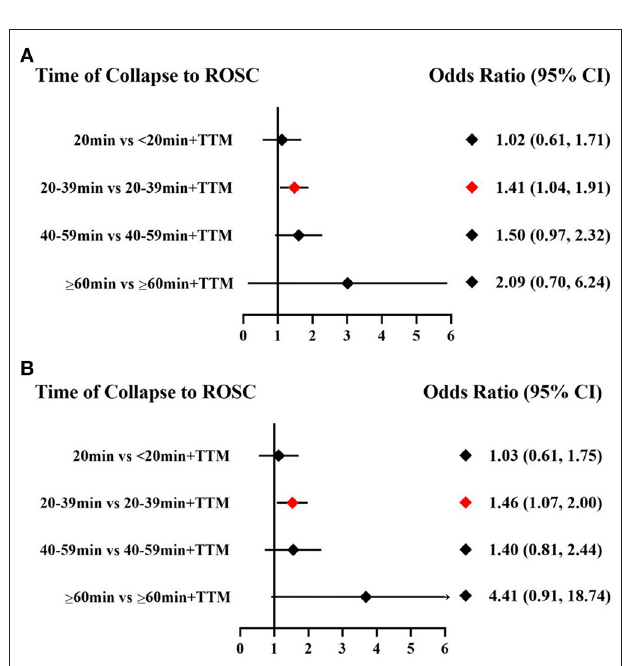
FIGURE 3 | Forest plot for survival (A) and good neurologic outcome (B) with the same time of collapse to ROSC.